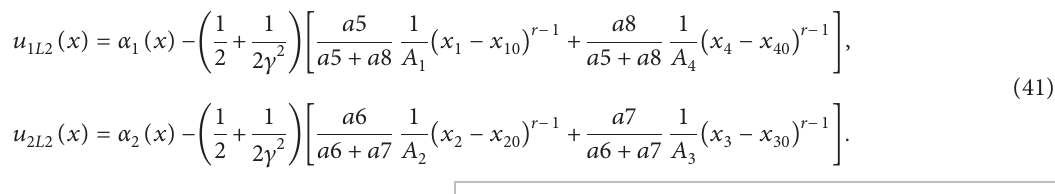
Figure 4: Comparisons of liquid levels with disturbances between the finite-time control law (33) and the L law